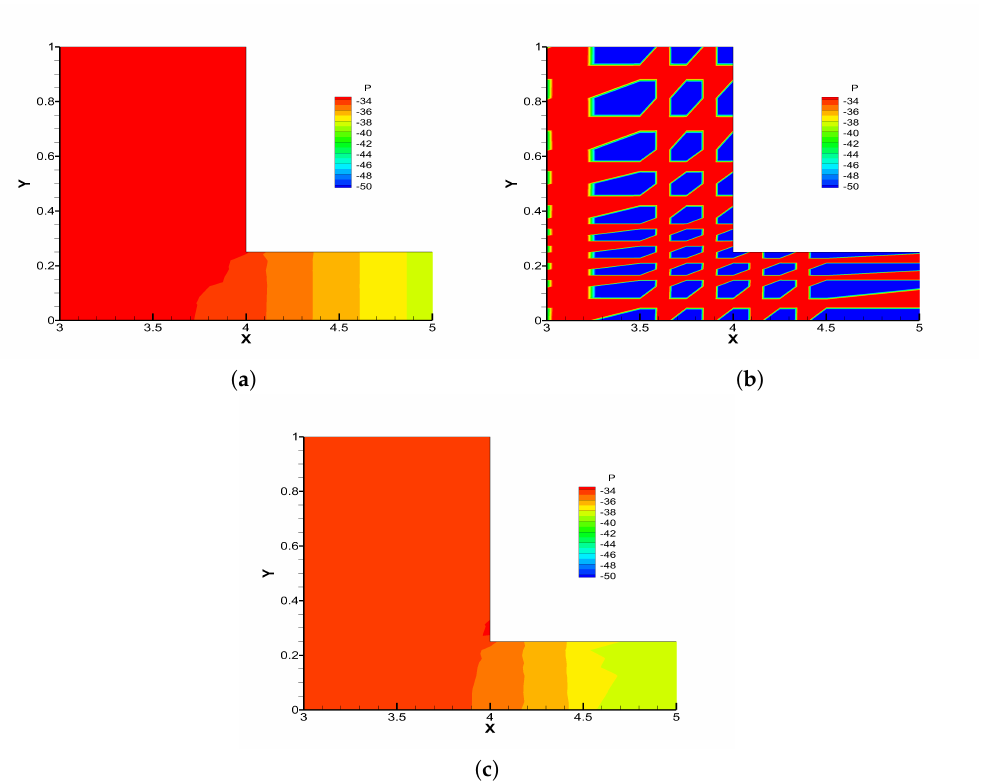
Figure 6. The pressure contours for pressure gradient p with different elements. From left to